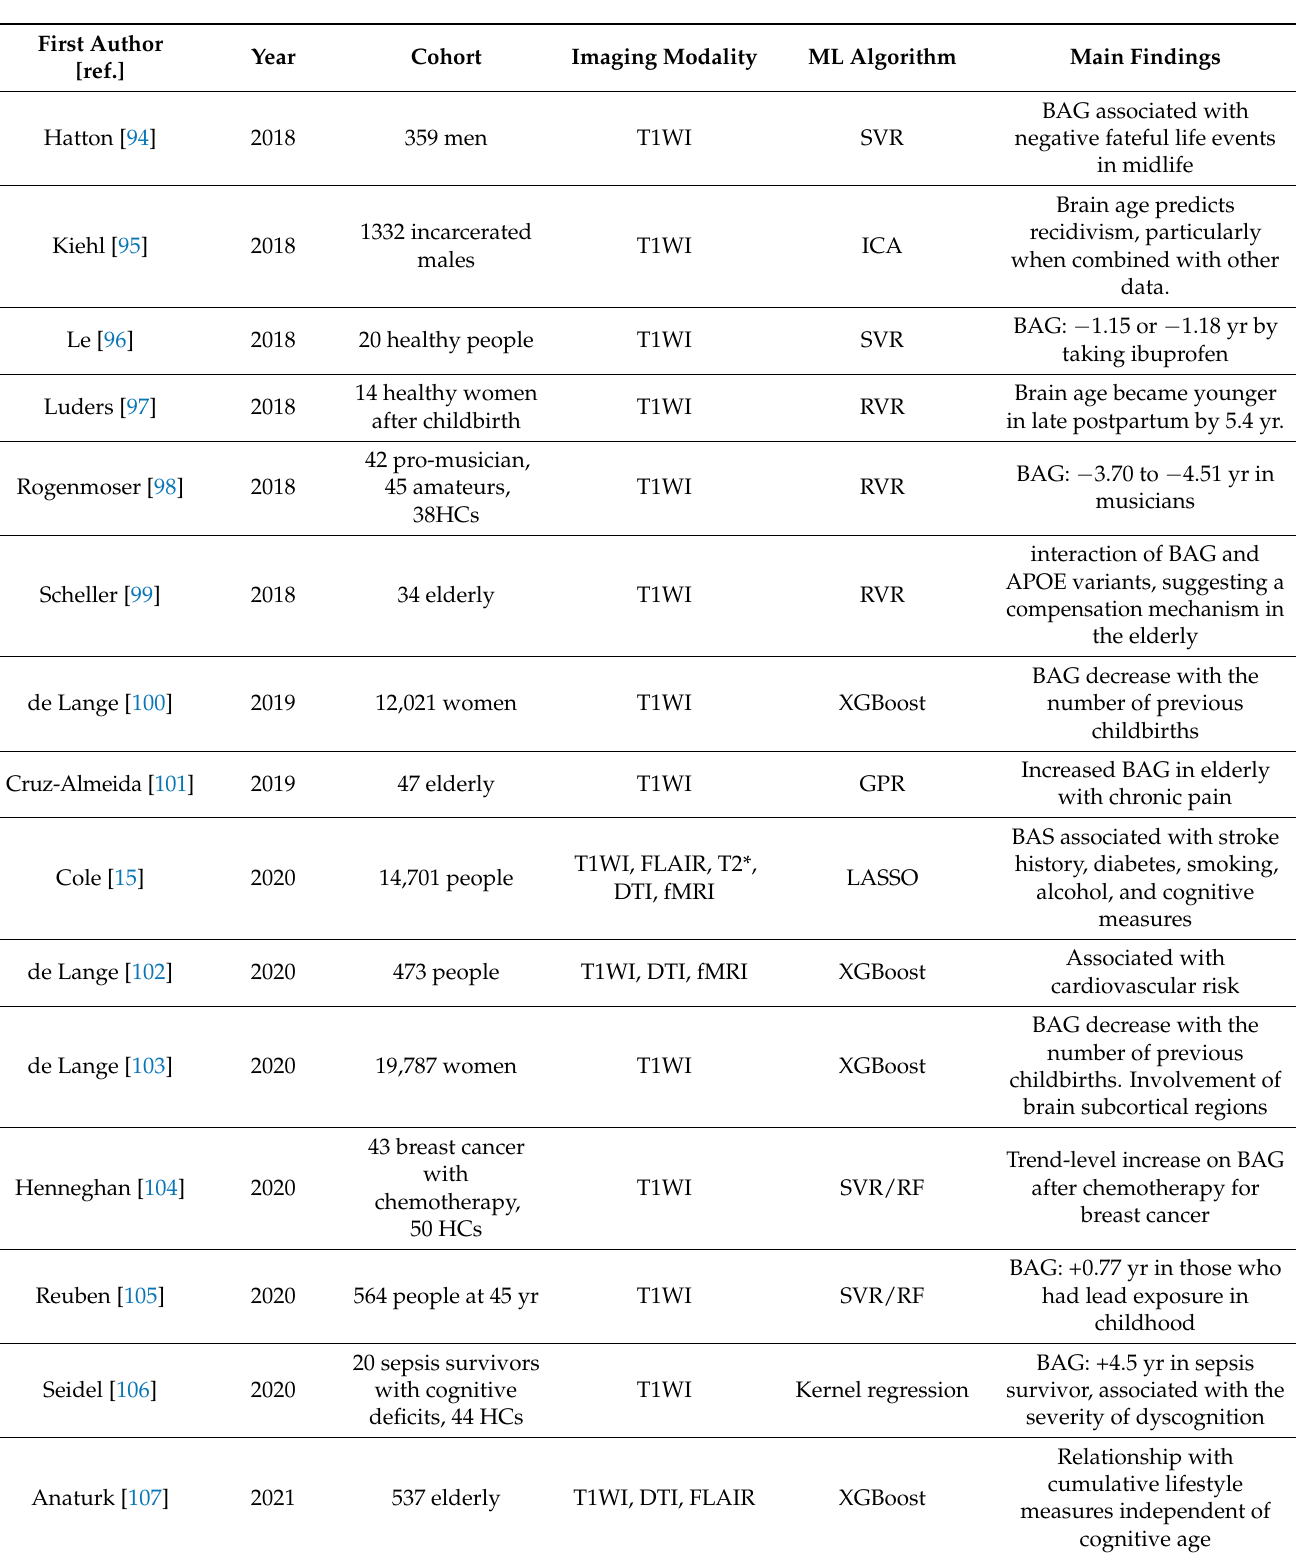
BAG: − 3.70 to − 4.51 yr